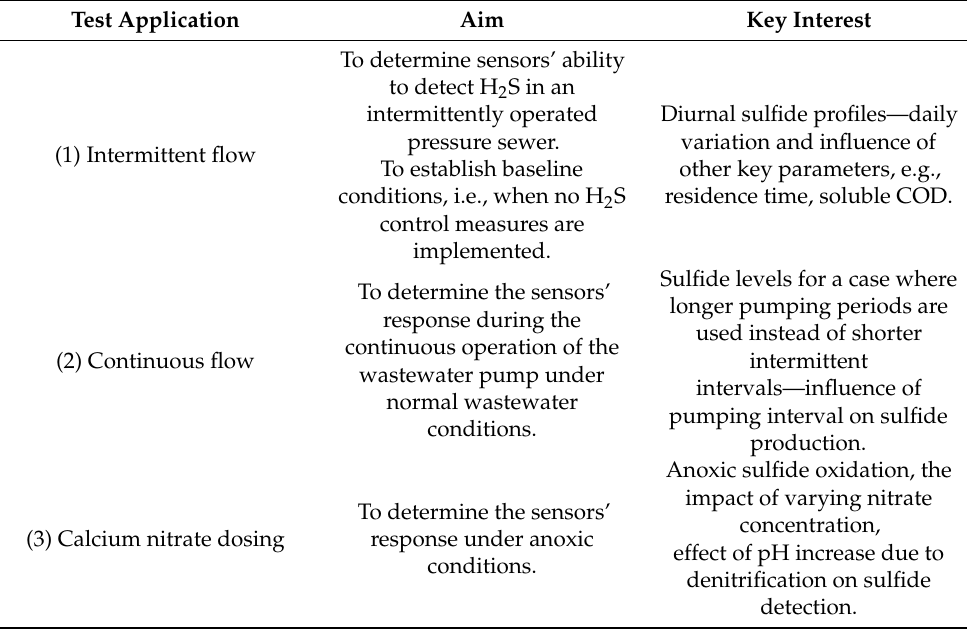
Table 2. Summary of the test applications made in phase 2 of the study to test the performance of online sensors under realistic sewer